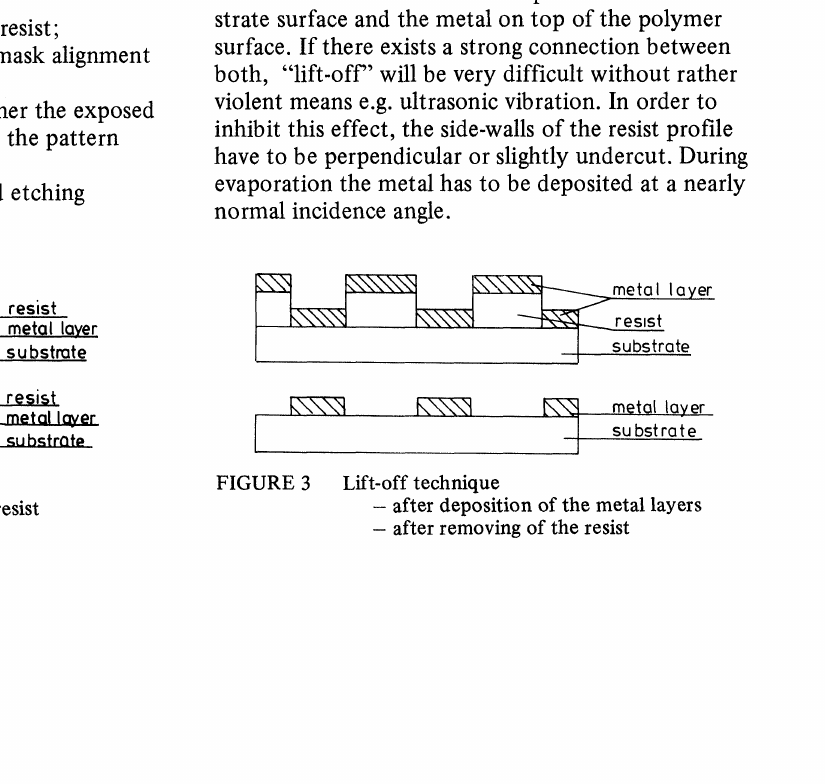
Chemical etching process before exposure of the resist after chemical etching